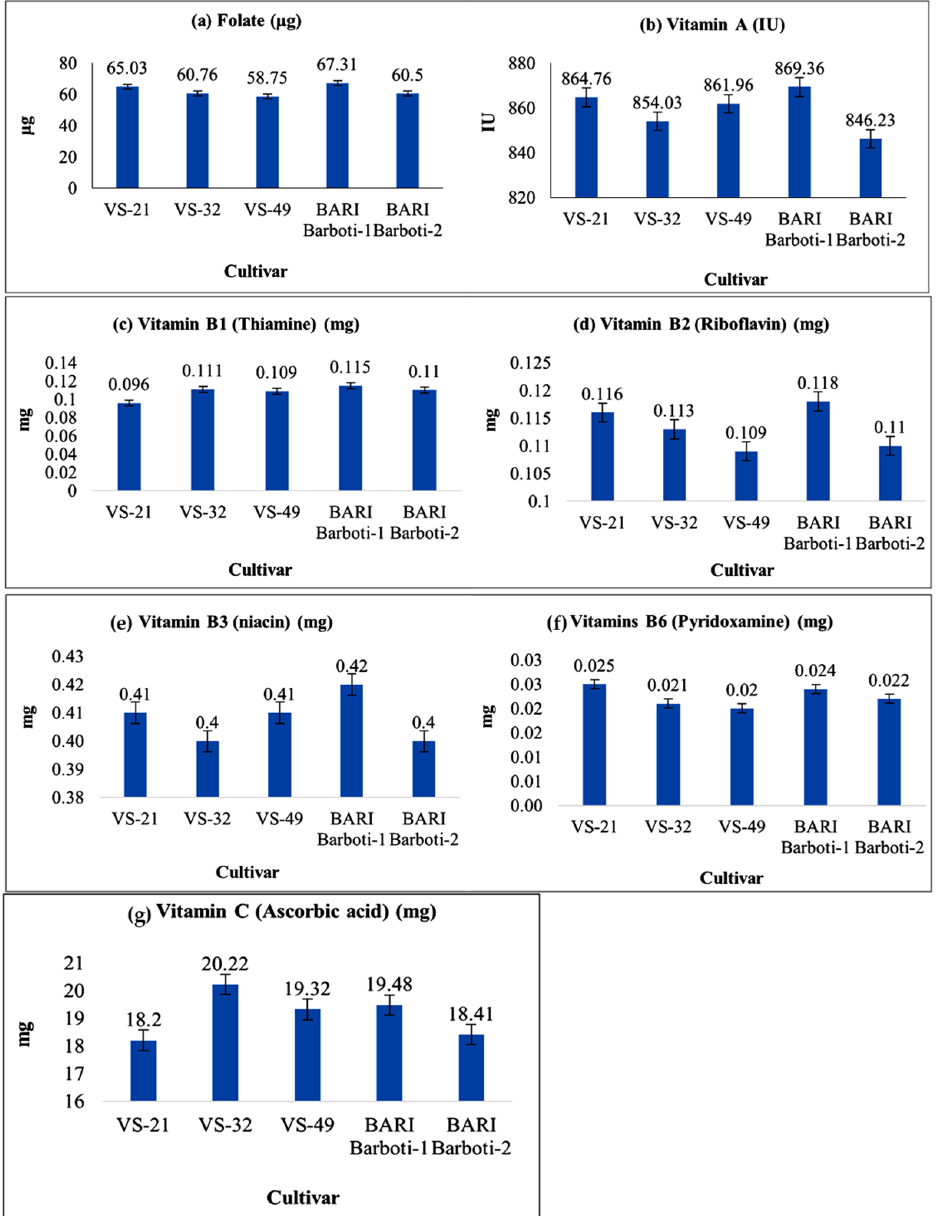
Figure 5. ( a ) folate, ( b ) vitamin A, ( c ) vitamin B1, ( d ) vitamin B2, ( e ) vitamin B3, ( f ) vitamin B6 and ( g ) vitamin C content of five-yard-long bean cultivars are commonly grown in Bangladesh [The parameters were estimated from 100 g dry matter].